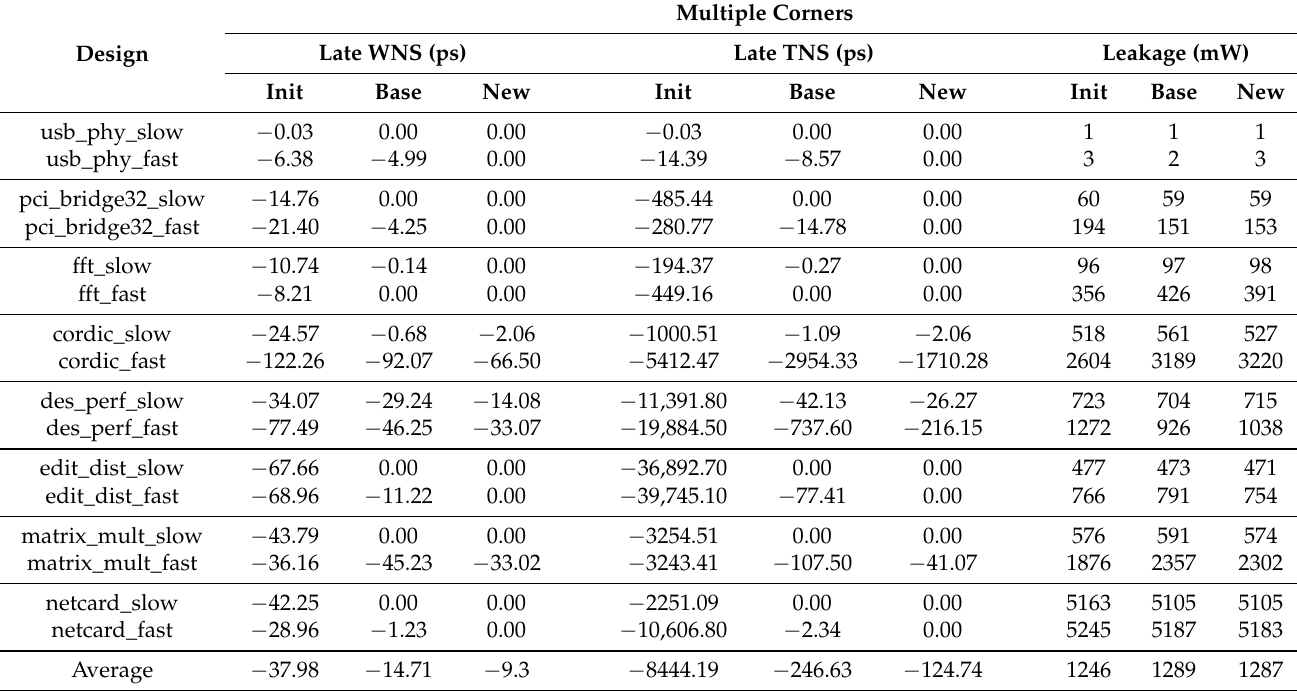
Table 2. Timing and leakage power of all designs under multiple corners initially nd at end of incremental LR − based